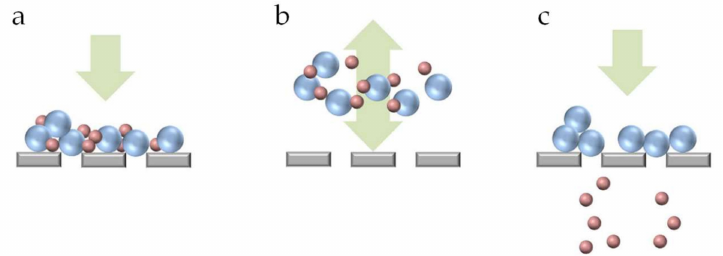
Figure 6. ( a ) Particle deposition on top of the filter. ( b ) Particles moving away from the filter